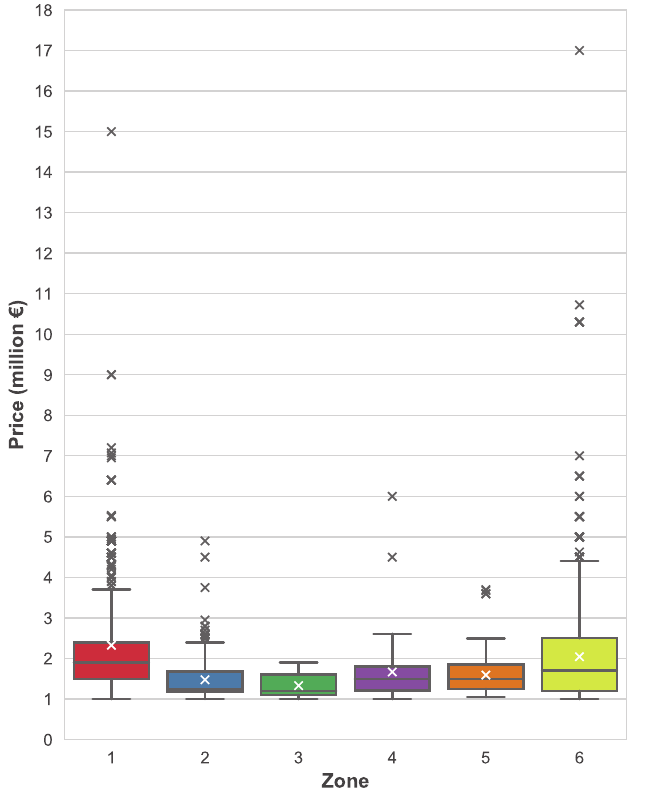
Figure 5. Boxplot of the distribution of prices based on the asset